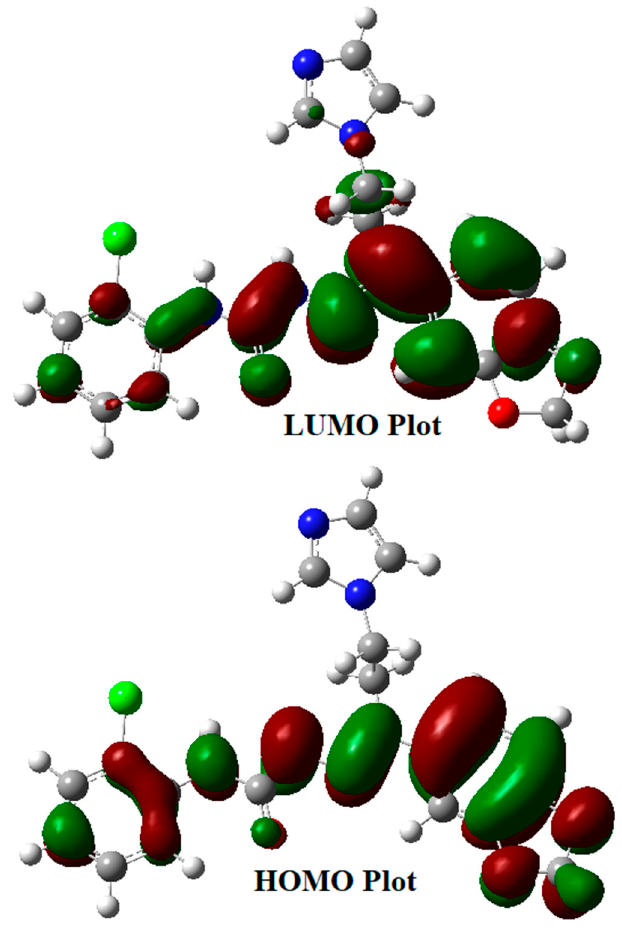
Figure 5. Frontier molecular orbitals of the semicarbazone 4 .